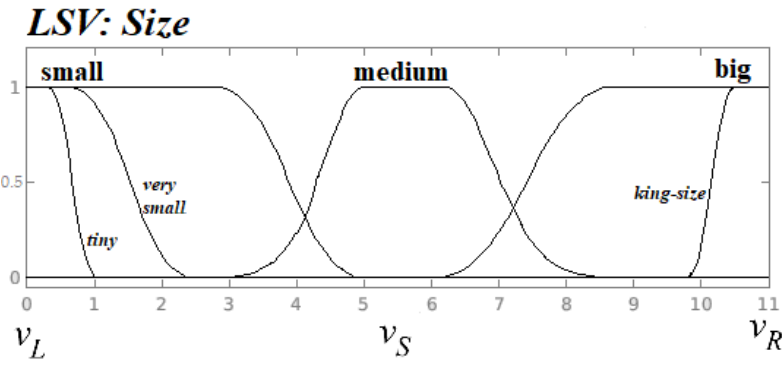
Figure 5. Trichotomous Expression of [ small-medium-big ] in FNL. We have taken the SO-CAL lexicon and re-distributed its adjective-lexical units.